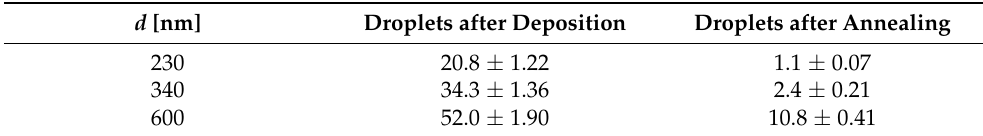
Table 1. Experimental average number of Ga droplets in the area of mask apertures of varied diameters d , determined using